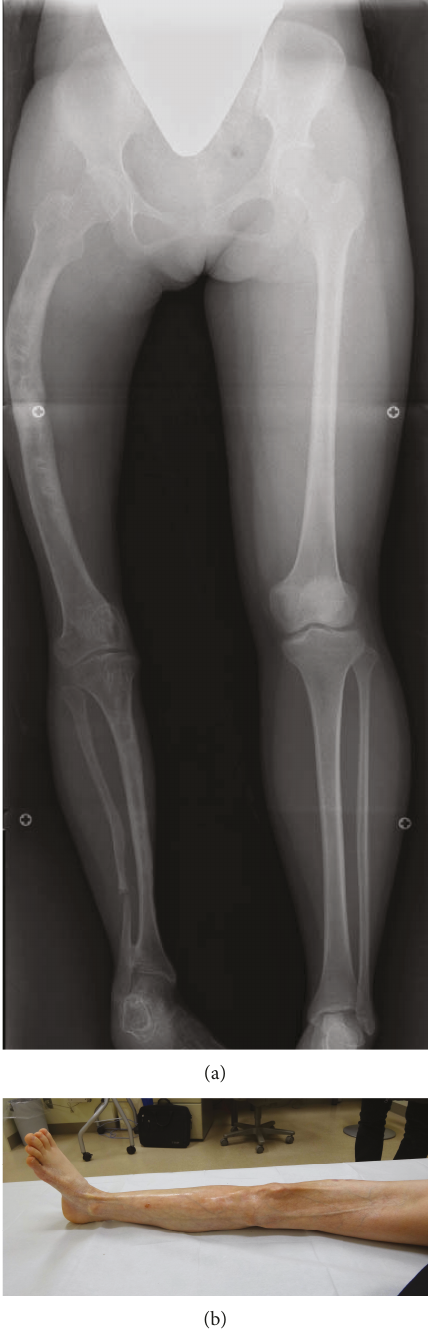
Figure 3: Current radiograph and view of the lower extremities. (a) An anteroposterior supine radiograph of the lower extremities at 17 years of age showing an anterolateral bowing of the right femur and a medial bowing of the right tibia. (b) A postoperative view of the right lower extremity showing atrophic skin surfaces on the posteromedial aspect of the thigh and the medial aspect of the lower leg, where brown pigmented cutaneous lesions were observed at the fi rst